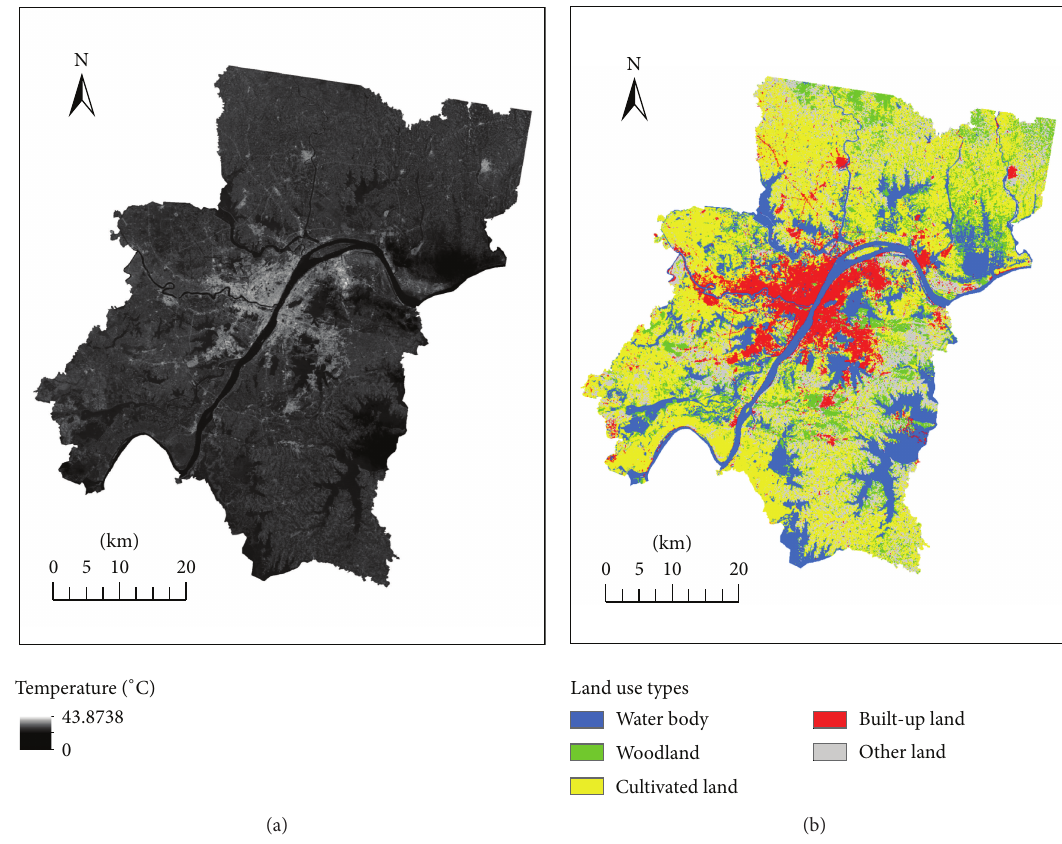
Figure 3: Land surface temperature (a) and land use map (b) in Wuhan